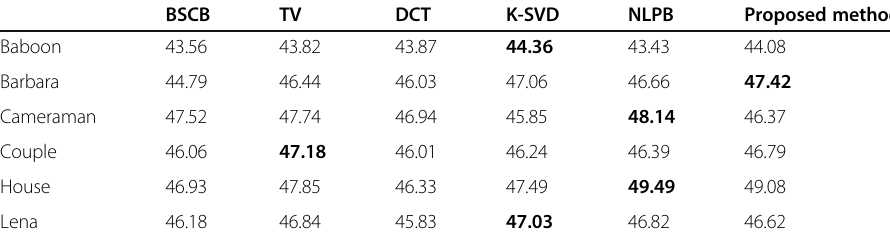
House 46.93 Lena